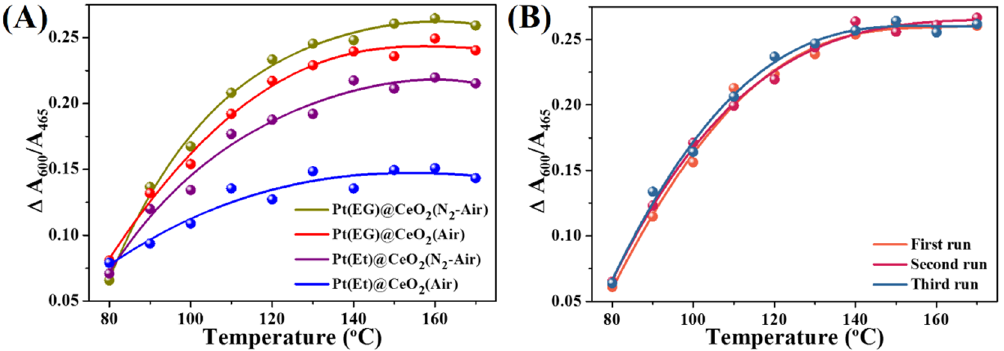
Figure 6. ( A ) Gaseous oxygen activation ability of various functional MOF derivatives. ( B ) Gaseous oxygen activation ability of Pt(EG)@CeO 2 (N 2 -Air) in the three